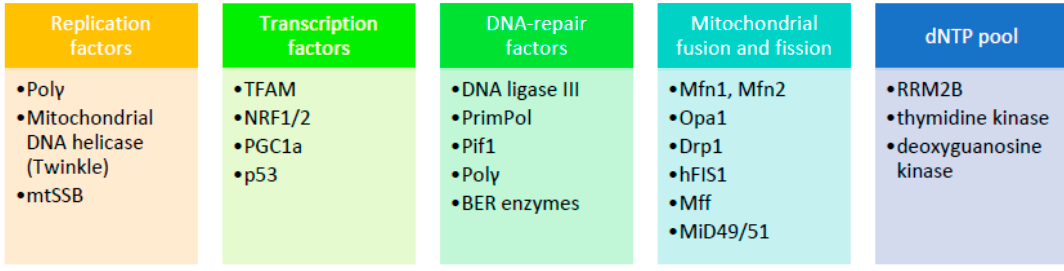
Figure 3. Summary of factors mentioned in the text that are associated with instability of mammalian mitochondrial DNA. The list presented herein is not exhaustive. (Pol γ : polymerase γ , mtSSB: mitochondrial single stranded DNA binding protein, TFAM: mitochondrial transcription factor A, NRF1/2: nuclear respiratory factors 1 and 2, PrimPol: primase-polymerase; Pif1: petite integration frequency 1, BER: base excision repair, Mfn: mitofusin, Opa1: optic atrophy protein 1,Drp1: dynamin related protein 1,hFIS1: fission 1 protein, Mff: mitochondrial fission factor, MiD49/51: mitochondrial dynamics proteins of 49 and 51 kDa, RRM2B: ribonucleoside-diphosphate reductase subunit M2 B).